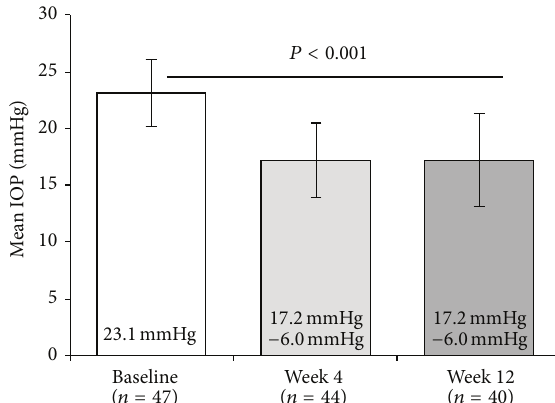
Figure 1: IOP reduction from baseline at weeks 4 and 12. Bars represent mean IOP ± SD; mean IOP reduction from baseline is indicated inside bars. IOP = intraocular pressure. Baseline versus week 12, 𝑃 < 0.001 ; 1-way analysis of variance with a post hoc, 2- sided paired 𝑡 -test.